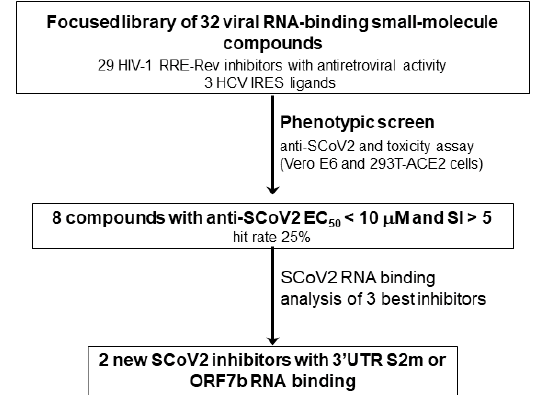
Figure 1. Phenotypic strategy used for identifying RNA-binding small molecules with anti-SCoV2 activity.